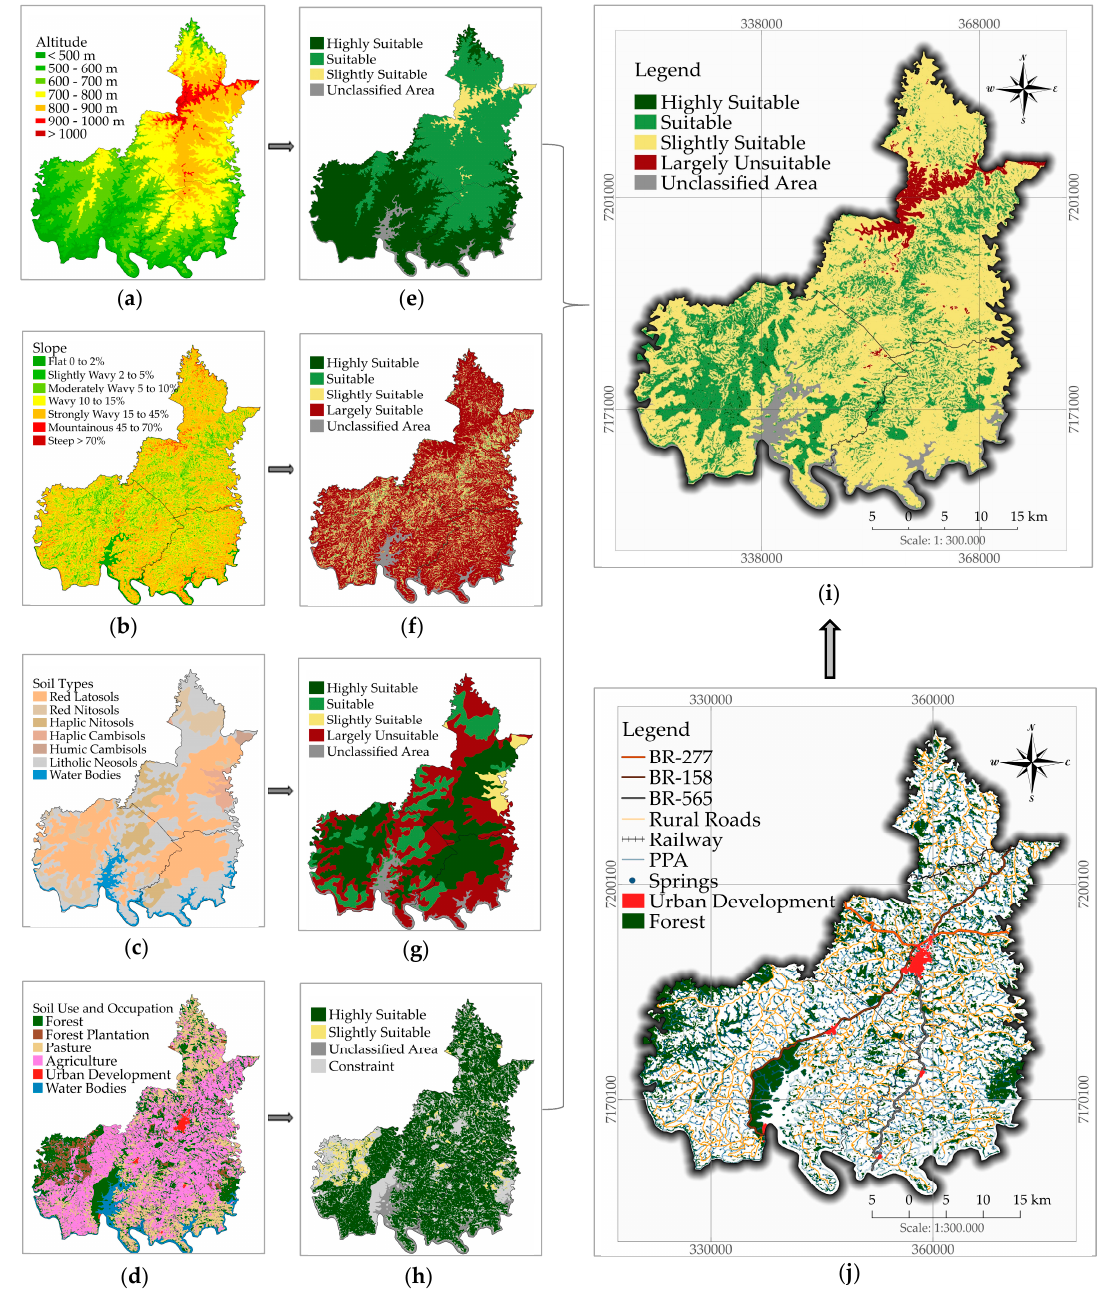
Figure 5. Information plan (IP) ( a – d ): thematic maps; IP ( e – h ): suitability scale maps; IP ( i ) fish farming suitability classification map; IP ( j ) map showing constraints on fish farming.